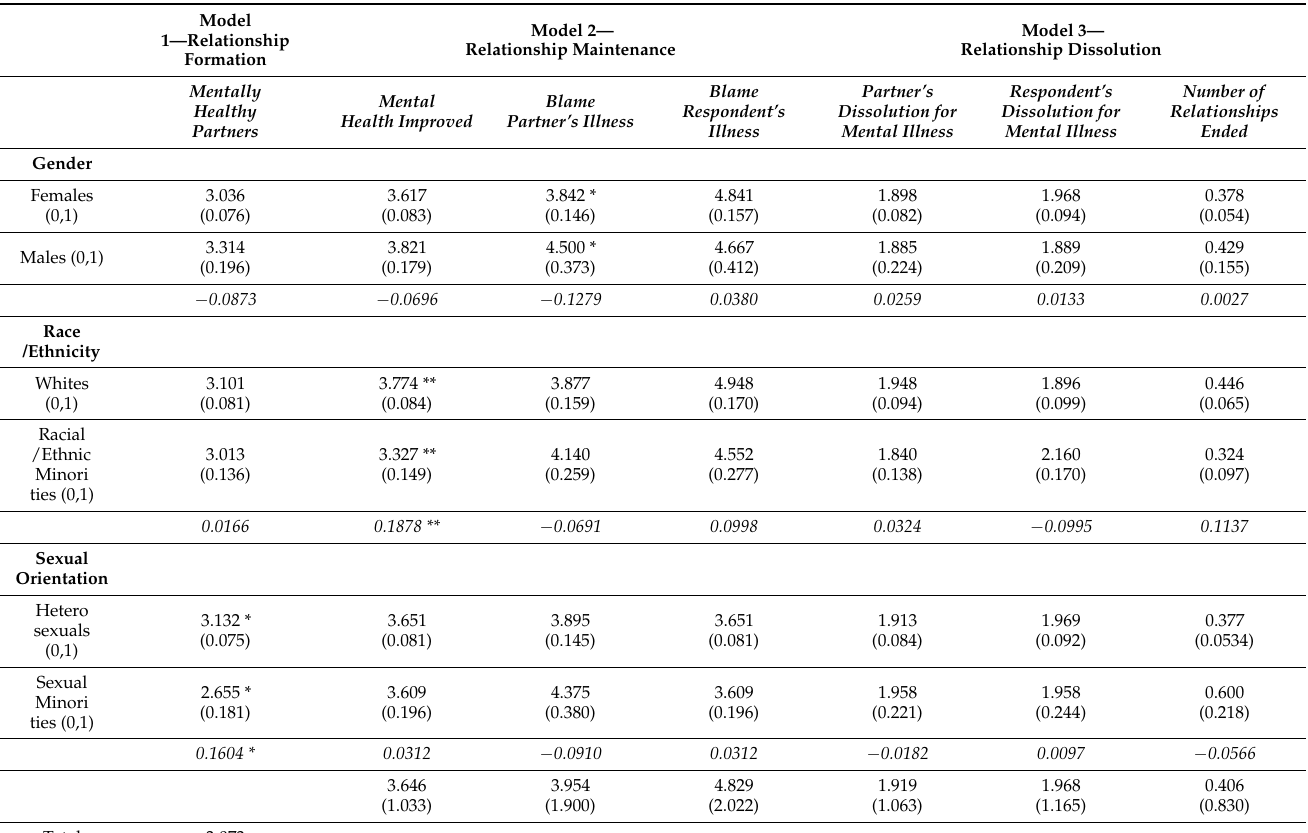
Table 2. Spearman’s Correlation Coefficients of Mental Illness Problems and Romantic Relationships 1